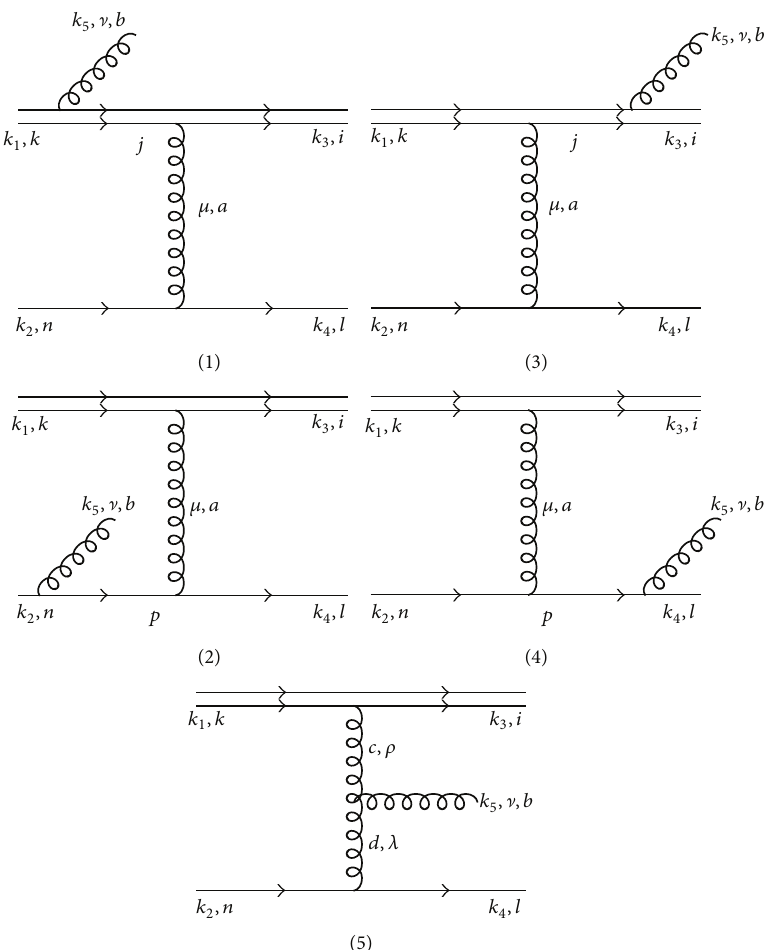
Figure 1: Feynman diagrams corresponding to the process 𝑄𝑞 → 𝑄𝑞𝑔 . Double line denotes heavy quarks. 𝑖,𝑗, 𝑘, 𝑙,𝑛, 𝑝 are all quark colours. 𝑎, 𝑏,𝑐, 𝑑 are gluon colours and Greek indices denote gluon